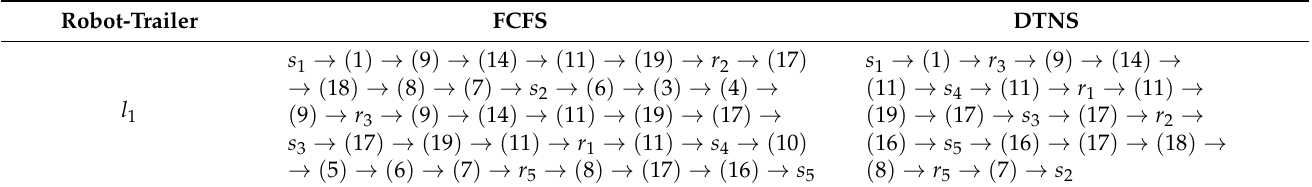
Table 10. Paths obtained by FCFS and DTNS under the condition of one robot-trailer in scenario 2. Robot-Trailer